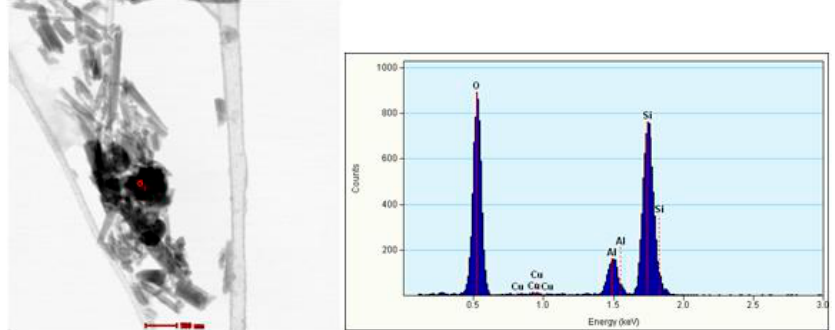
Figure 10. TEM-STEM (bright field) imaging and EDX data for HNT phase identification.